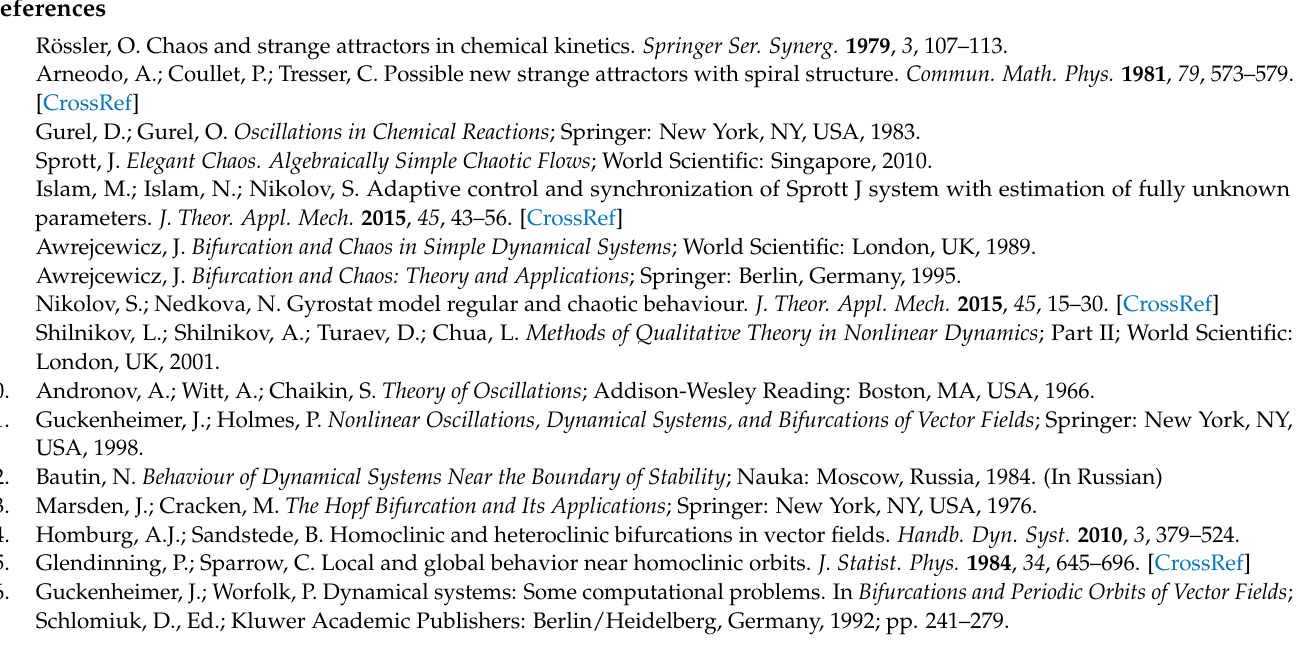
Figure A4. Pseudo-chaotic (order in chaos) solution ( a ) and strange attractor ( b ) for system (1), when 5.0,51.0 == ba .